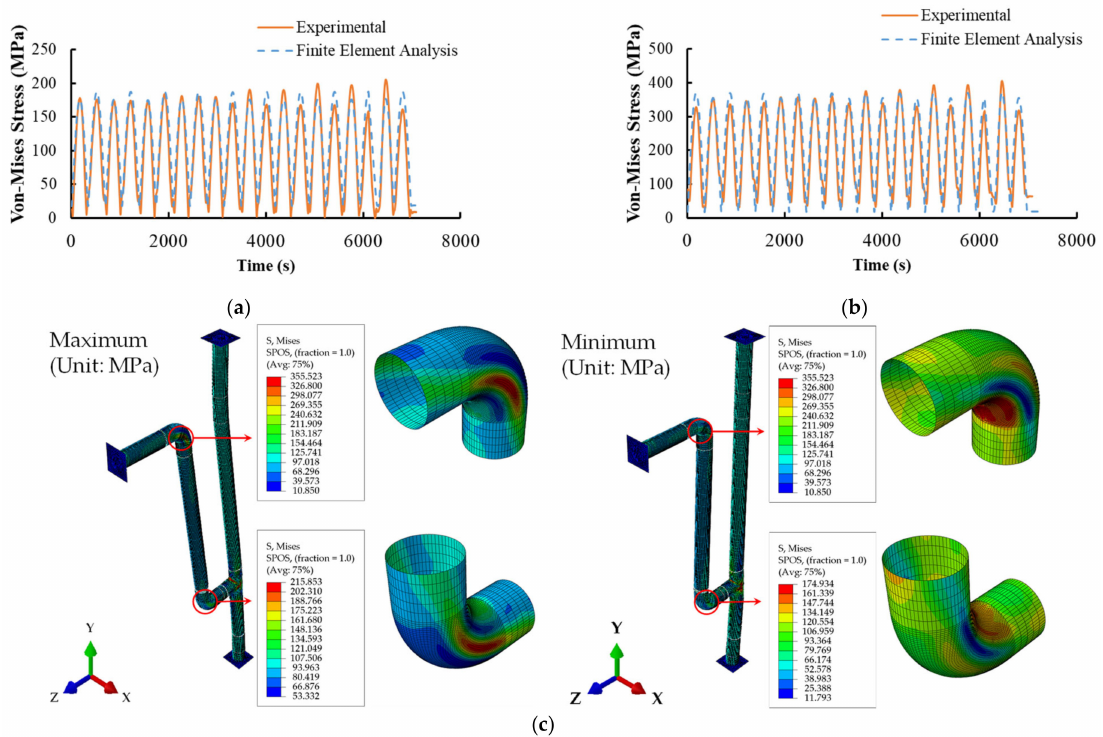
Figure 10. Validation of the von Mises stress of the large-scale press-to-connect piping system: ( a ) lower elbow; ( b ) upper elbow; ( c ) maximum and minimum stress distributions.